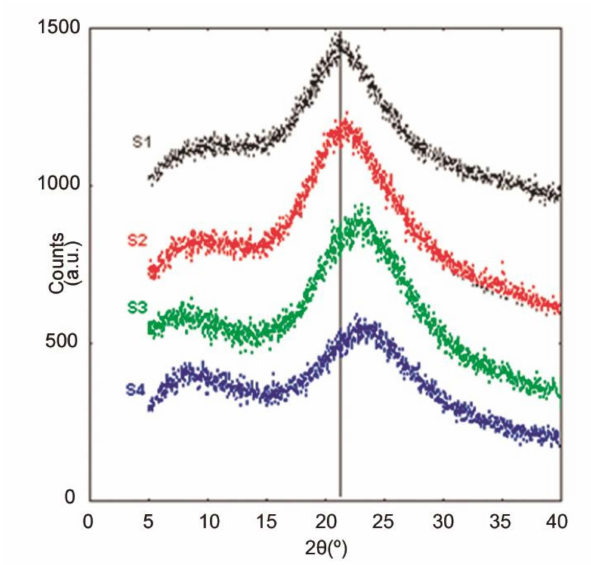
Figure 3. The X-ray powder di ff raction (XRPD) spectra of a-silica (S1–S4) using various alkali silica reaction (ASR) times, where the x-axis is 2 θ and the y-axis is the intensity in arbitrary units. The vertical line represents the peak maxima of the starting